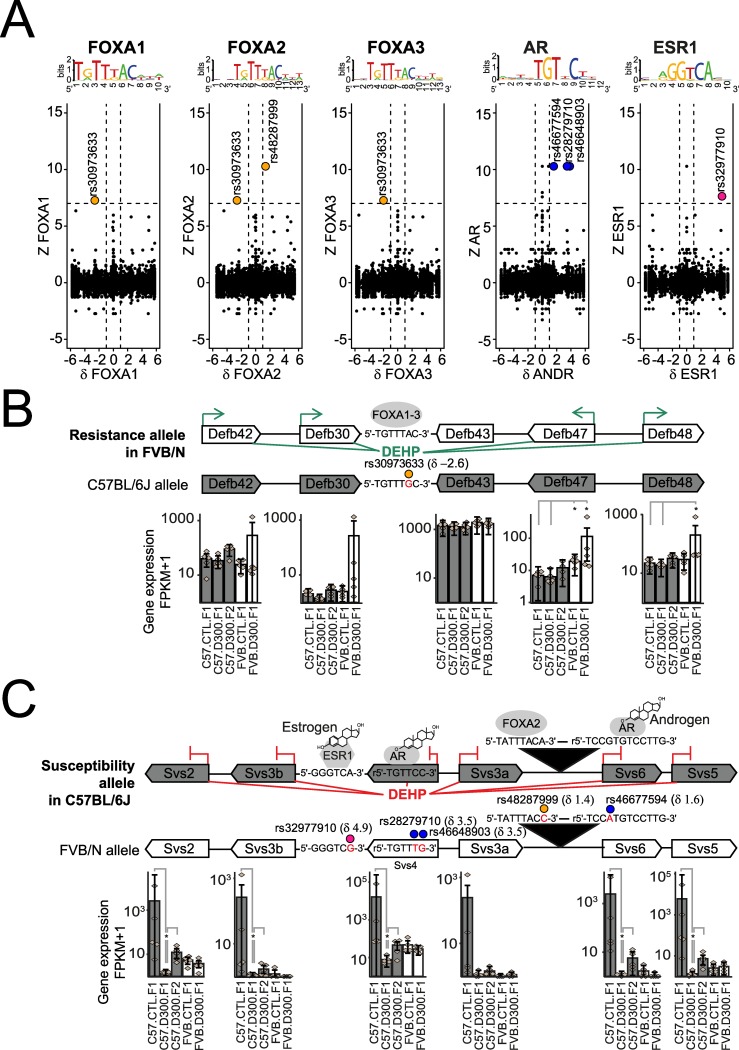
Genome-wide analysis of SNP impacting SHP motifs in function of strain-specific dysregulation of male germ cell RNAs.(A) Genome-wide analysis of DEHP-induced and strain-specific transcriptional changes (Z) in the function of strain-specific binding site (δ) for FOXA1, FOXA2, FOXA3, AR and ESR1. Z = log2 (FPKM FVB.D300.F1 / FPKM FVB.CTL.F1)—log2 (FPKM C57.D300.F1/ FPKM C57.CTL.F1). δ = score C57BL/6J –score FVB/N. The corresponding logos above each graph represent the tested motif. Dashed lines represent thresholds. (B) FVB/N-specific DEHP-induced increased expression in the β-defensin loci associated with an FVB/N-specific FOXA1-3 binding motif due to rs30973633. Upon prenatal exposure to DEHP, increased expression levels are recorded for Defb42, Defb30, Defb47 and Defb48, but not for Defb43 in FVB/N, without changes in C57BL/6J. (C) C57BL/6J-specifc DEHP-induced expressional changes in the Svs loci associated with C57BL/6J-specific binding sites for AR, ESR1 and FOXA2 due to SNPs rs28279710, rs46648903, rs46677594, rs32977910 and rs46677594. In utero exposure to DEHP resulted in decreased expression across all Svs genes in C57BL/6J with no change in FVB/N. (BC) Delta values in parentheses represent score differences between both alleles for the respective motif, taking the SNP into account. Stars represent statistically significant differences of expression levels, according to the non-parametric pairwise Wilcoxon test with Benjamini & Hochberg correction for multiple testing. In part C, statistically significant differences between both strains are not shown.